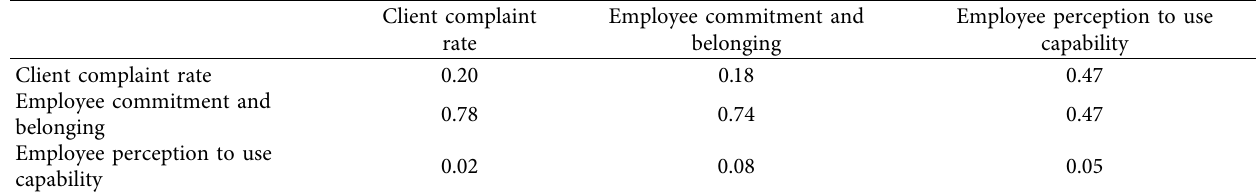
Table 6: Normalization table of analytic hierarchical process in customer perspective.